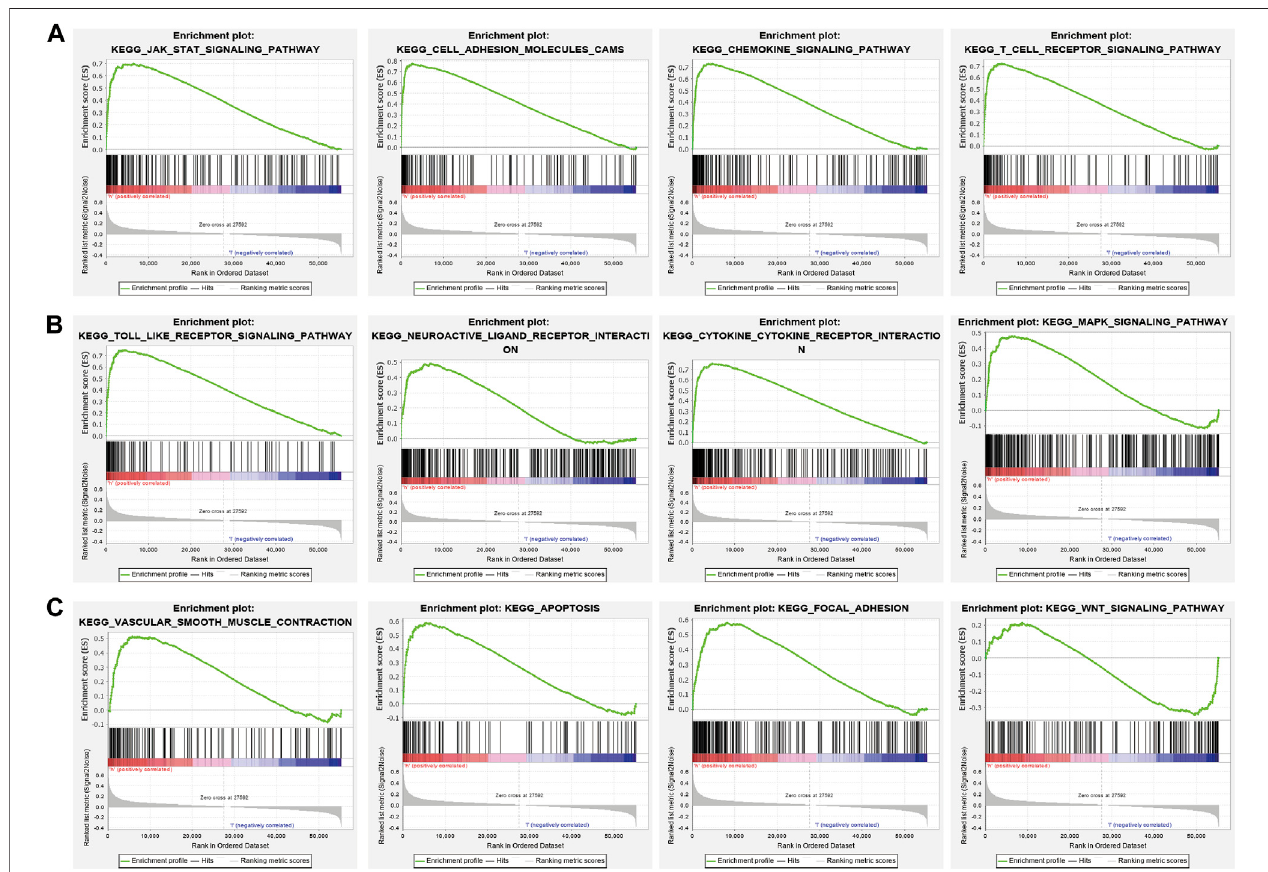
FIGURE 11 | GSEA enrichment PAFAH1B3-related signaling pathway in LIHC (A – C) GSEA enrichment PAFAH1B3-related signaling pathway in LIHC.